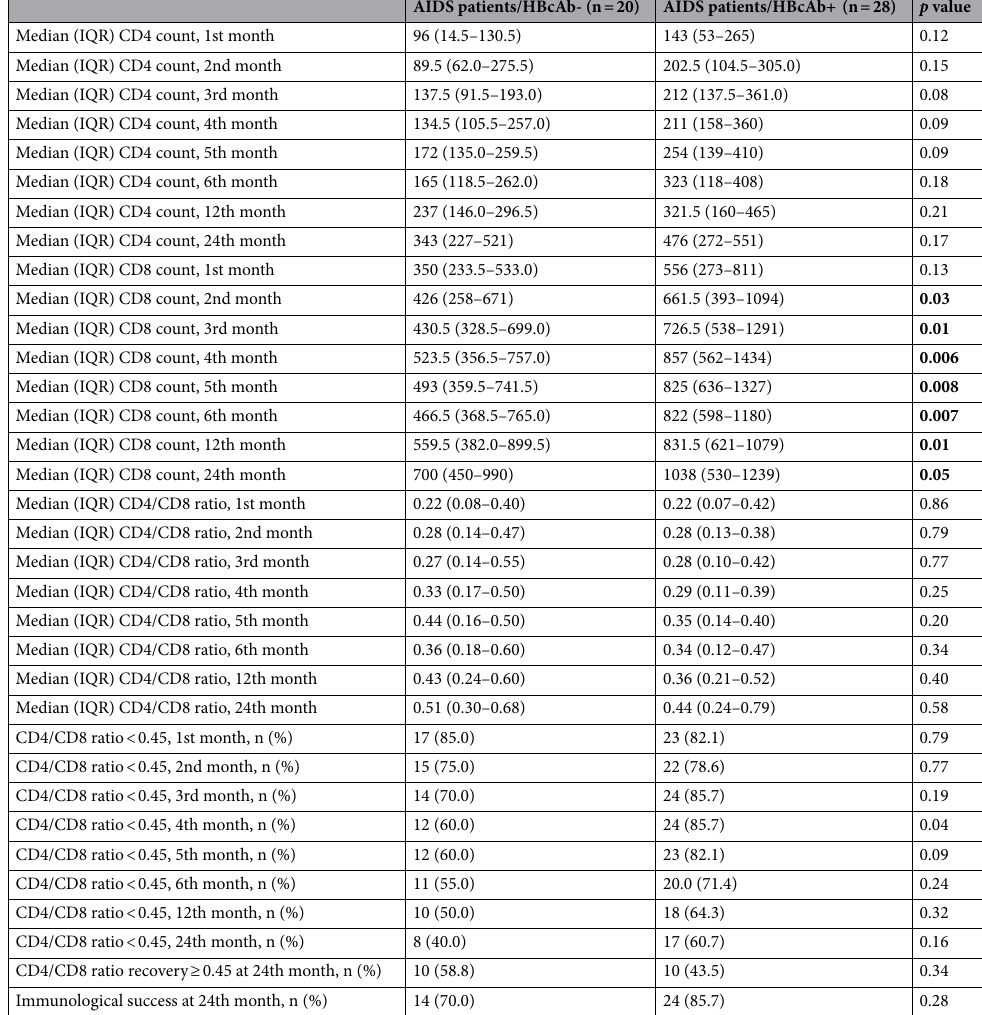
Table 2. Comparison between CD4+ and CD8+ T lymphocyte numbers and CD4/CD8 ratio improvement in the 24 months following the start of cART in the following two AIDS-presenting patient subgroups: HBcAb- positive and